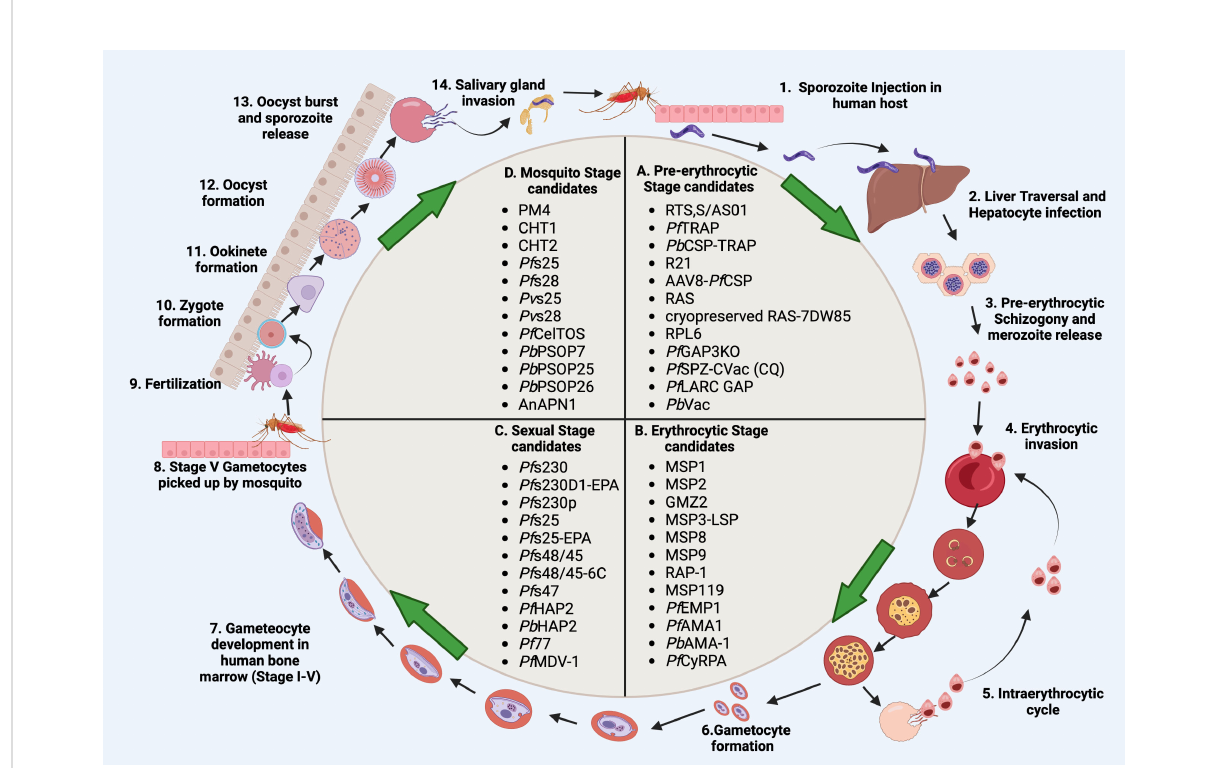
(B) Erythrocytic candidates MSP1, MSP2, GMZ2, MSP3-LSP, MSP8, MSP9, RAP-1, MSP119, Pf EMP1, Pf AMA1, Pb AMA-1, Pf CyRPA). (C) , Sexual stage candidates ( Pf s230, Pf s230D1-EPA, Pf s230p, Pf s25, Pf s25-EPA, Pf s48/45, Pf s48/45-6C, Pf s47, Pf HAP2, Pf HAP2p, Pb HAP2, Pf 77, Pf MDV-1). (D) Mosquito stage candidates PM4, CHT1, CHT2, Pf s25, Pf s28, Pv s25, Pv s28, Pf CelTOS, Pb PSOP7, Pb PSOP25, Pb PSOP26, AnAPN1). Steps 1-14 show the malaria parasite life cycle which completes in four stages; pre-erythrocytic, erythrocytic, sexual, and mosquito stages. During the